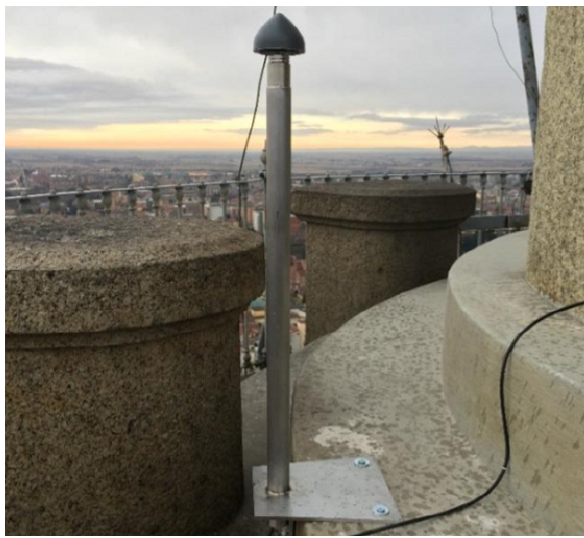
Figure 2. Monumentation of one of the two antennas on the concrete basement